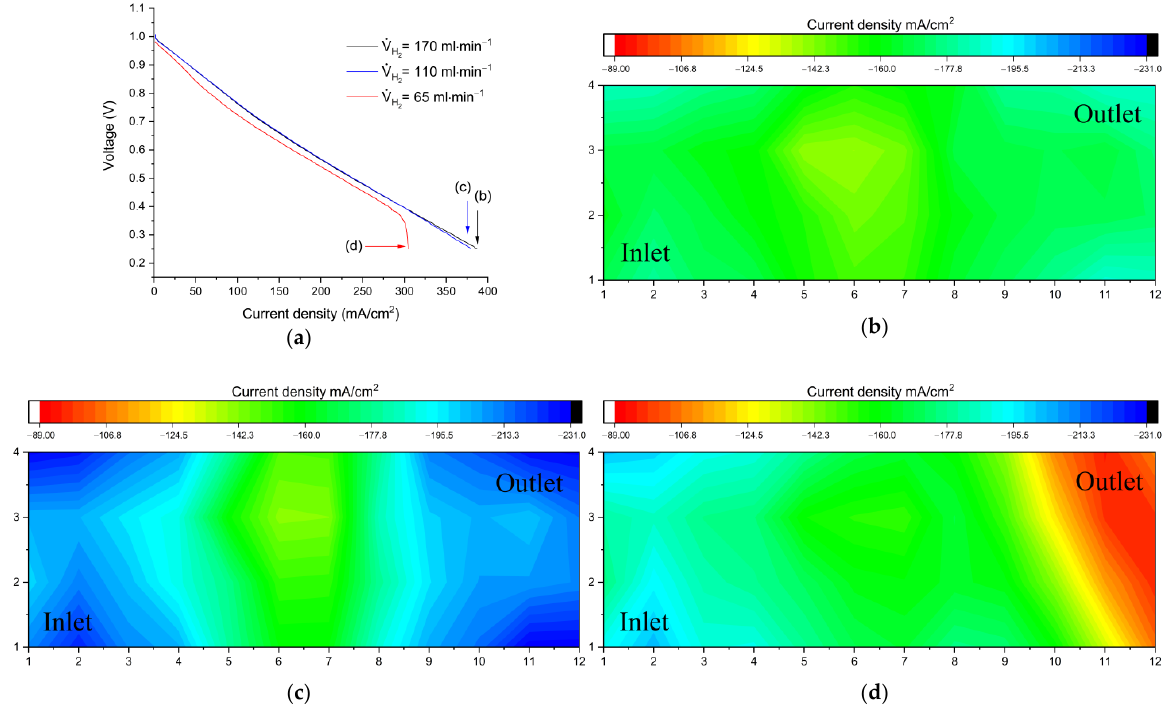
Figure 4. ( a ) Polarization curves (discharge) for different anolyte flow rates and corresponding current distributions at limiting conditions for ( b ) V H2 = 170 mL min — 1 , ( c ) V H2 = 110 mL min — 1 , and ( d ) V H2 = 65 mL min — 1 . The supply of Br 2 solution was fixed to V Br2 = 30 mL min — 1 .